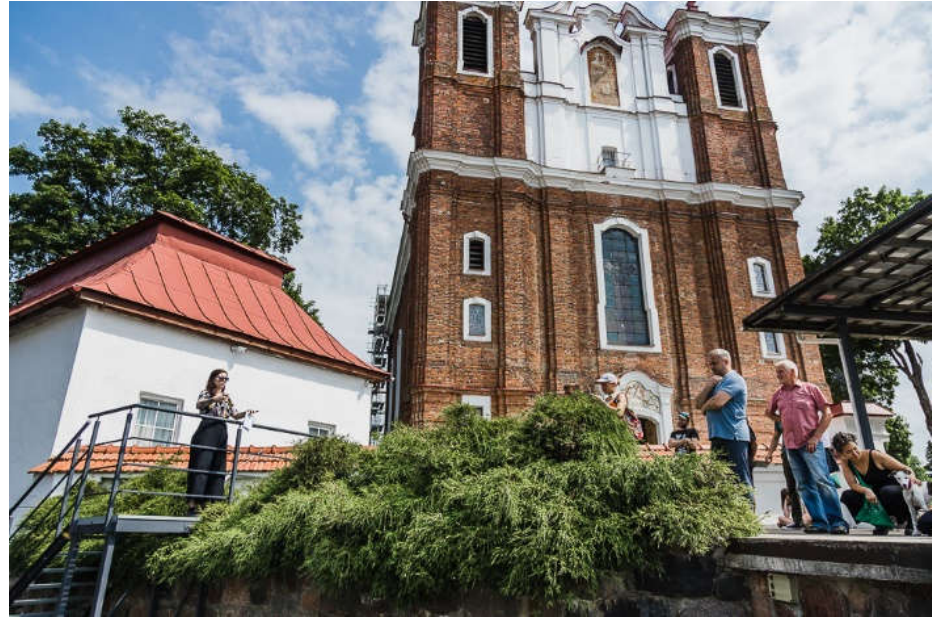
Figure 10. Saint Mary‘s birth basilica [1775] in Šiluva during the theatre biennial. Photo by Sigitas Figure 10. SaintMary‘sbirthbasilica[1775]inŠiluvaduringthetheatrebiennial. PhotobySigitas Gudaitis.